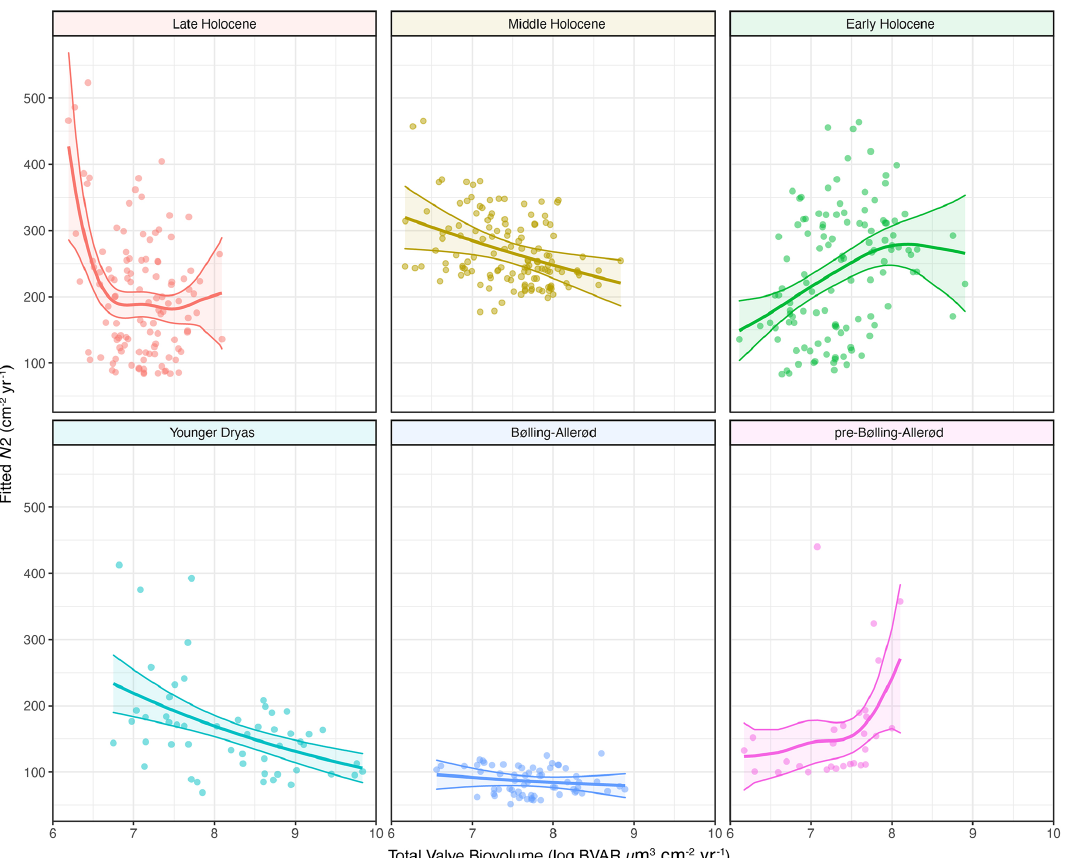
Figure 7. Palaeoproductivity–diversity relationships explored using generalized additive models (GAMs) that allow different smoothings for the pre-defined climatic periods: pre-Bølling–Allerød, (Bølling–Allerød), Younger Dryas, Early Holocene, Middle Holocene, and Late Holocene. The dots represent the data points, the thick line is the fitted GAM response for each period, and the shaded areas represent the 95% confidence intervals around the mean fitted